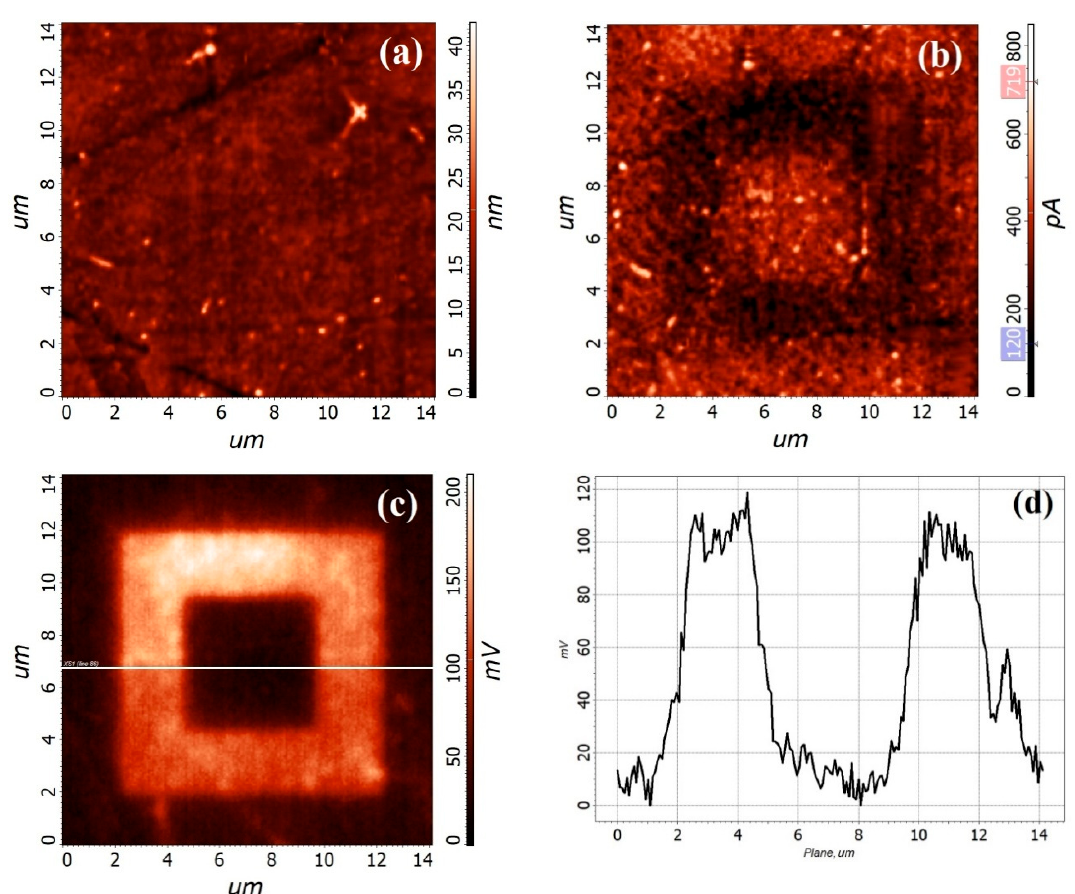
Figure 11. AFM image of the electroforming-free nanocrystalline ZnO film surface: ( a )—morphology, ( b )—current contrast, ( c )—potential distribution, and ( d )—profilogram along the line in ( c ).